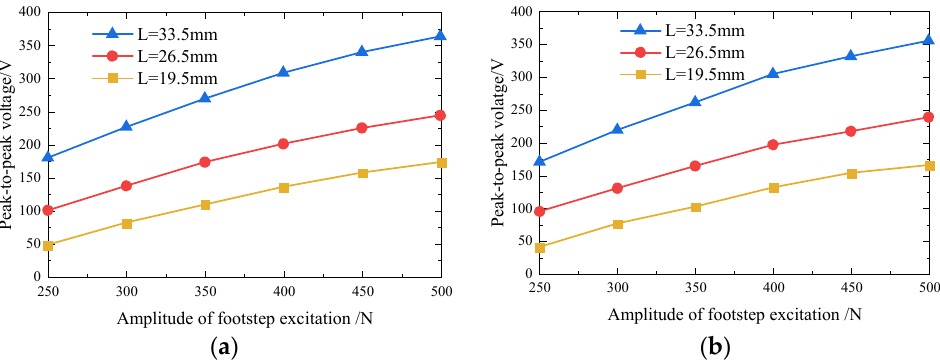
Figure 10. Peak-to-peak voltages from PZT4 patches of 2#1 on unimorph PCS1 and 2#3 on unimorph PCS2 of 2# piezoelectric brick versus the amplitude of footstep excitation ( f = 1 Hz). ( a ) 2#1 PZT4 patch; ( b ) 2#3 PZT4 patch .